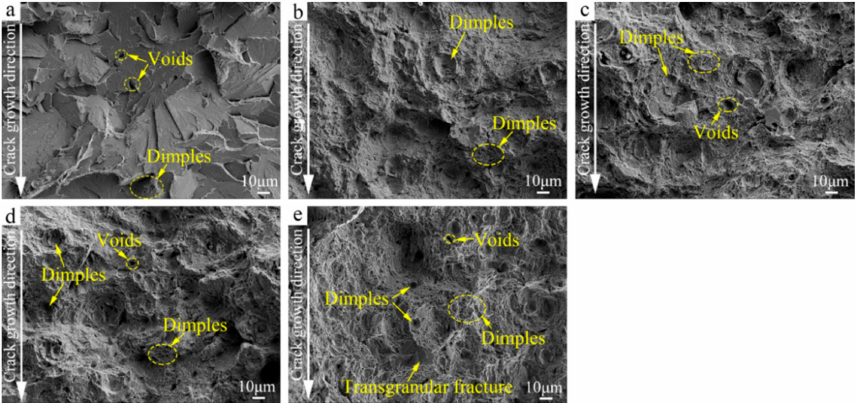
Figure 11. The fracture surface microtopography in the unstable region for ( a ) BM, ( b ) HDL, ( c ) HDT, ( d ) CFL, and ( e )